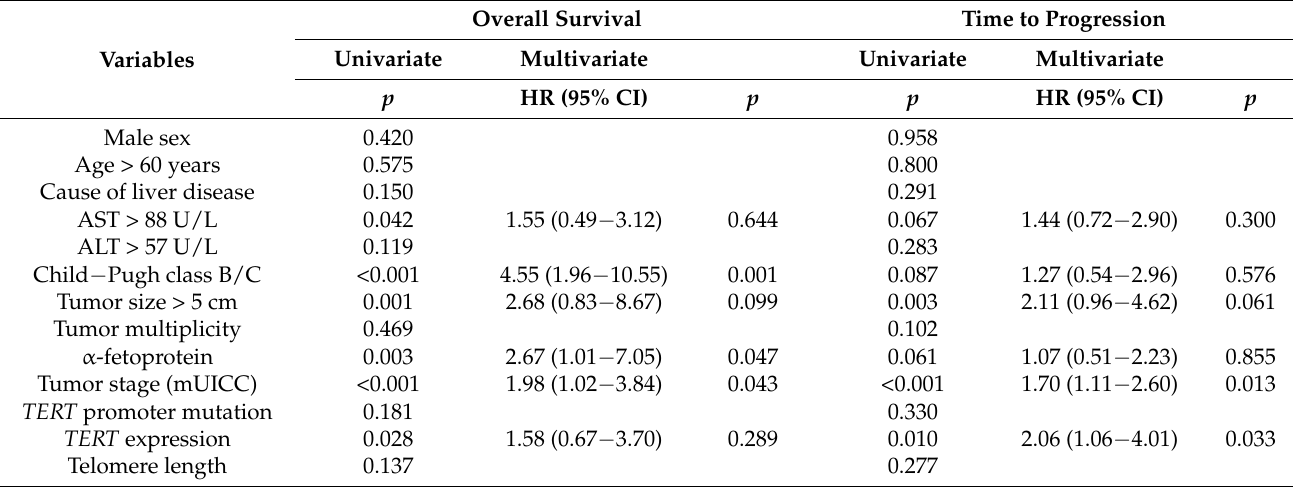
Table 3. Prognostic variables in patients undergoing TACE-based